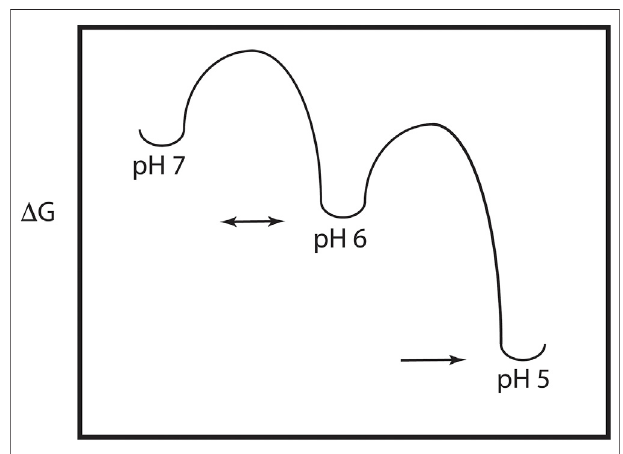
FIGURE 2 | Energy plot of the pH trigger in HA. Note that there may be multiple intermediate statesand thatthetransition tosomeoftheintermediate states may be